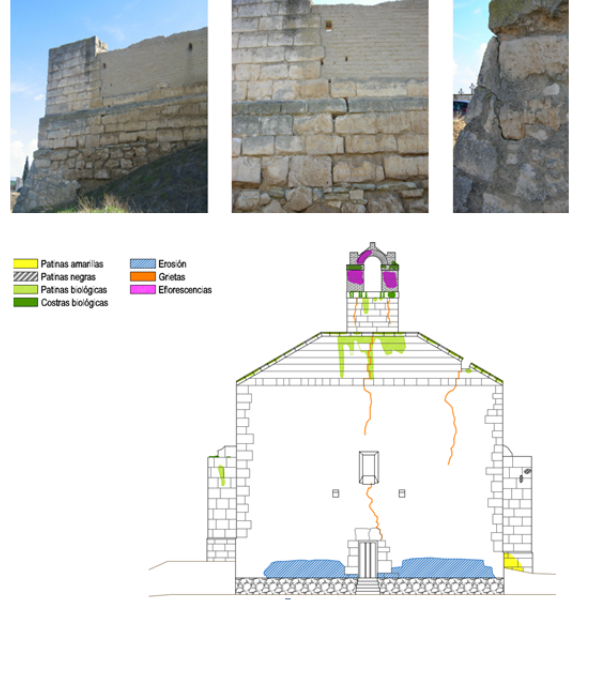
Figure 3: Identification and diagnosis.